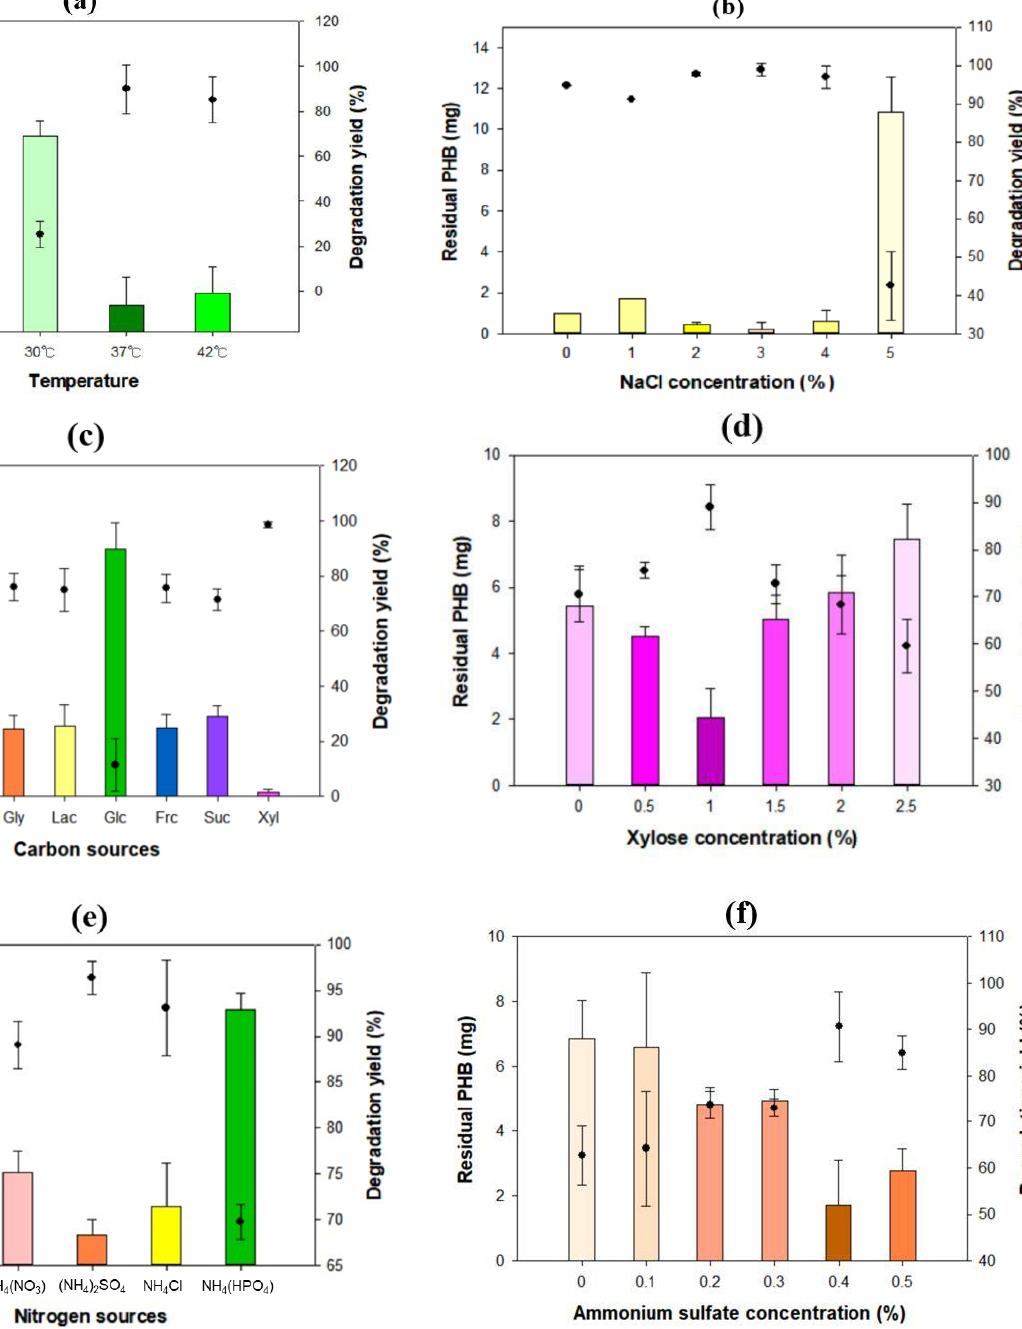
Figure 2. Optimal conditions for poly(3-hydroxybutyrate) (PHB) degradation ( a ) Microbulbifer sp. SOL66 cells were cultured at various temperatures ranging from 10 ◦ C to 42 ◦ C. ( b ) Microbulbifer sp. SOL66 cells were cultured with various concentrations of NaCl, ranging from 0% to 5%. ( c ) Various carbon sources were added, including galactose (Gal), glycerol (Gly), lactose (Lac), glucose (Glc), fructose (Frc), Sucrose (Suc), and xylose (Xyl). ( d ) Different concentrations of the xylose were added from 0% to 2.5% to determine the optimal concentration of the xylose. ( e ) Various nitrogen sources were added, including ammonium nitrate [(NH 4 )NO 3 ], ammonium sulfate [(NH 4 ) 2 SO 4 ], ammonium chloride [(NH 4 )Cl], and ammonium dihydrogen phosphate [(NH 4 ) H 2 PO 4 ]. ( f ) Different concentrations of the ammonium sulfate were added from 0% to 0.5% to determine the optimal concentration of the ammonium sulfate.